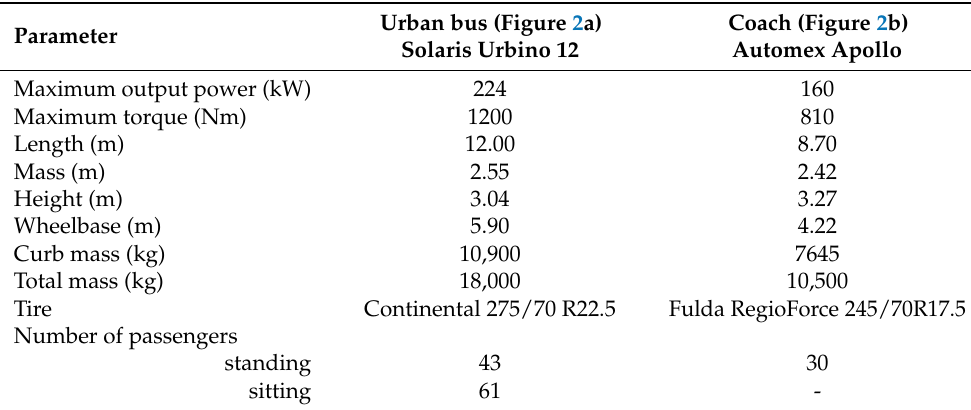
Figure 2. Test vehicles during acceleration and braking maneuvers: ( a ) urban bus, ( b ) coach. Table 1. Test vehicle technical parameters